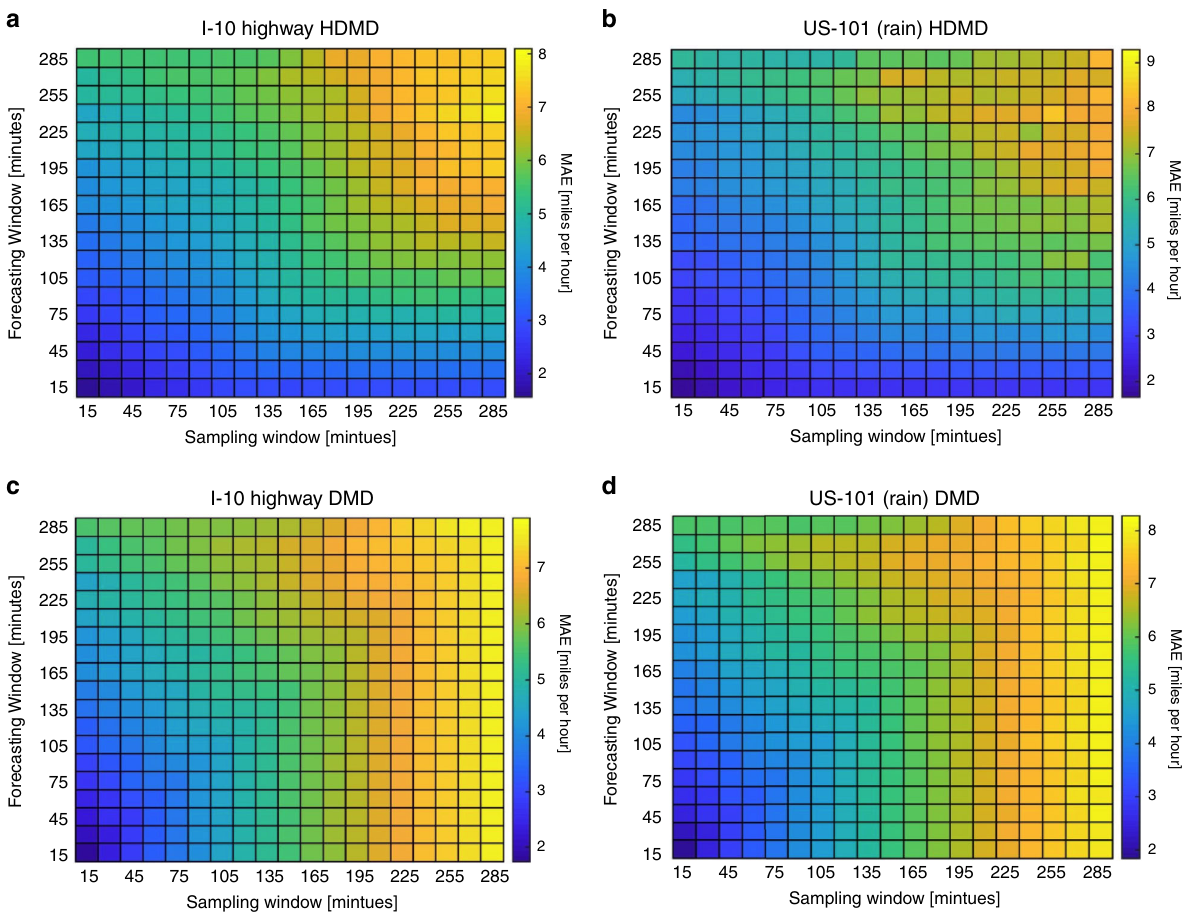
Fig. 8 Mean absolute error for various choices of ( s , f ). a , b The top row was generated utilizing the MH-DMD algorithm. c , d The bottom row was generated utilizing the DMD algorithm. It is evident that the Hankel-DMD can provide greater accuracy than a standard DMD analysis. This is best seen by observing the increase of blue-colored squares in ( a , b ) versus ( c , d ). In both cases, the results suggest that the forecasting of traf fi c is a temporally